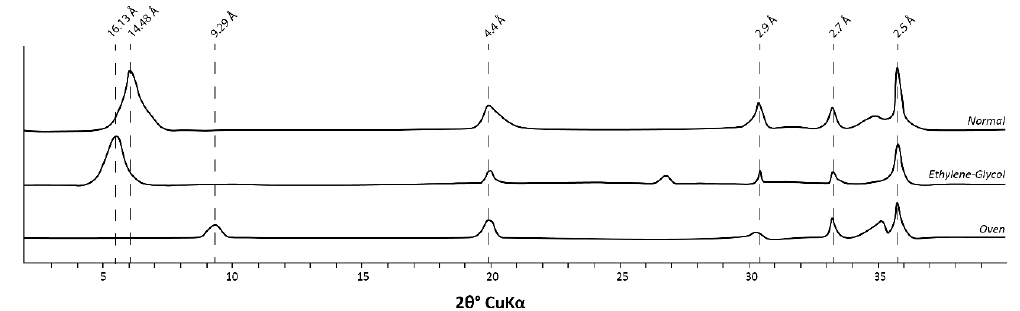
Figure 14. XRD signals obtained for sample DJI-4-1 (altered sample). Three signals are shown, for the unprocessed clay sample, the sample after ethylene glycol pulverization, and the sample after oven drying at 500°C.